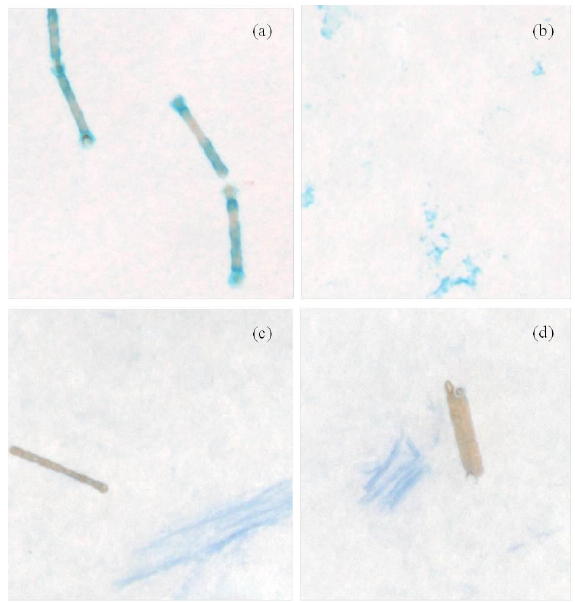
1024 Fig. 4. Microscopic view of Nodularia spumigena cultures covered with a mucus coating (a) , stained TEP (b) , and CSP (c, d)